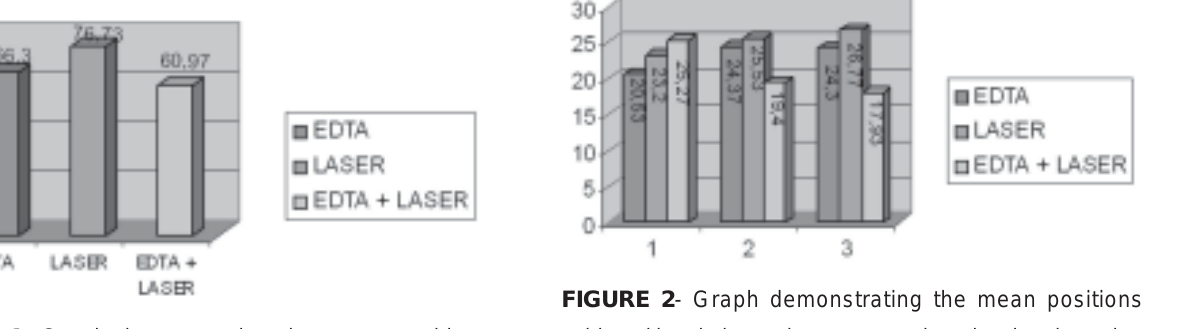
FIGURE 1 - Graph demonstrating the mean positions achieved in relation to the scores assigned to the obturation of the lateral canals, regardless of the third evalueted